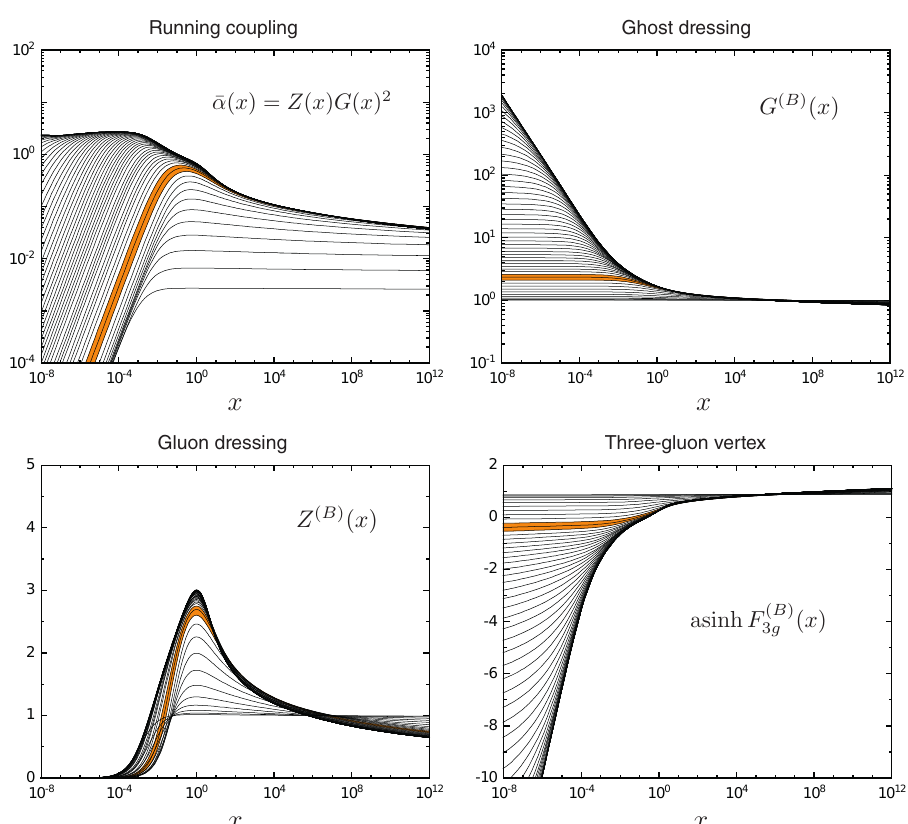
Figure 4: Solutions for the running coupling and the ghost, gluon and three-gluon vertex dressing functions at a fixed value of β and varying α . [ 5 ]